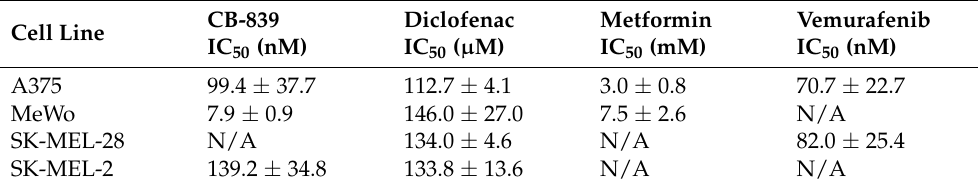
Table 2. IC 50 values for monotherapy with CB-839, diclofenac, metformin and vemurafenib *.